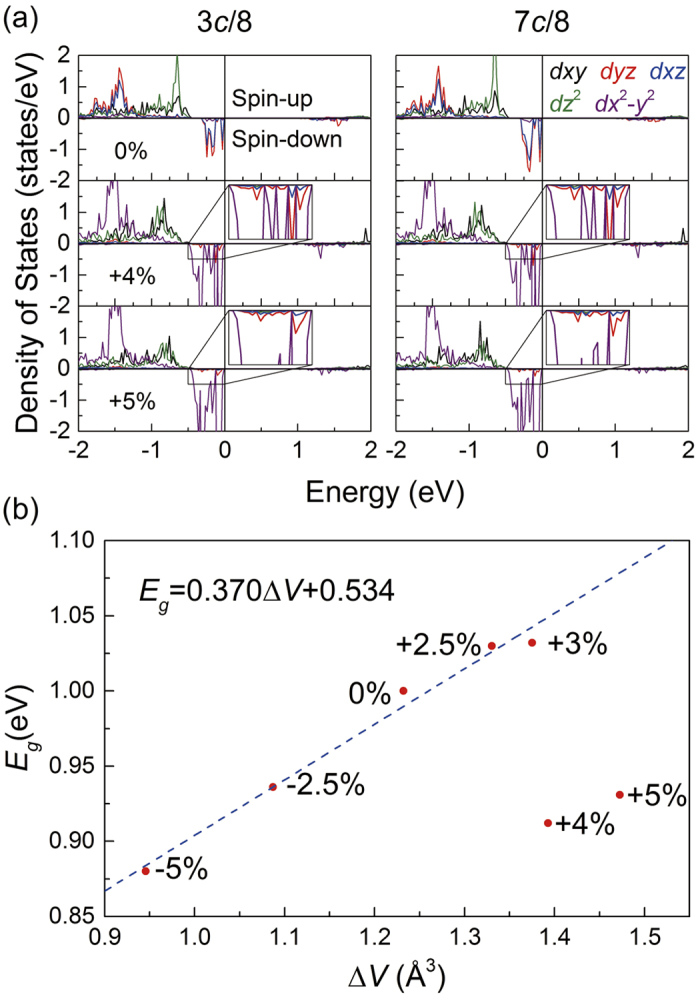
(a) PDOS of Fe(B42) plotted on 3d orbits with a strain of 0%, +4% and +5% at 3c/8 (left panel) and 7c/8 (right panel), respectively. The correspondent local magnifications are shown in the inset. (b) The dependency between the band gap Eg and the corresponding average FeO6 volume difference ΔV with different strains.